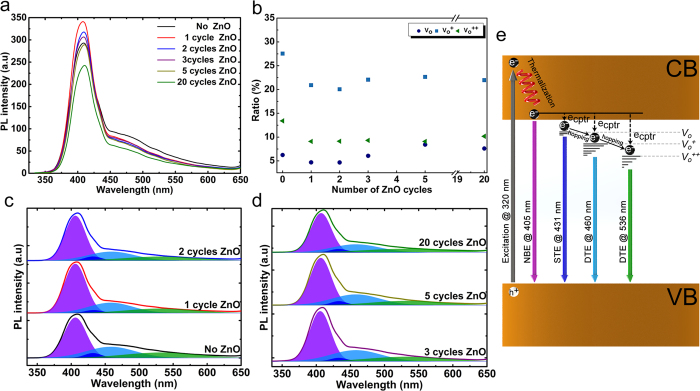
(a) PL spectra for the coated and bare samples at an excitation wavelength of 320 nm, (b) the ratio of peak intensities (ISTE/INBE and IDTE/INBE) for the (c,d) corresponded deconvoluted peaks and (e) depiction of the processes associated with each of these peaks.